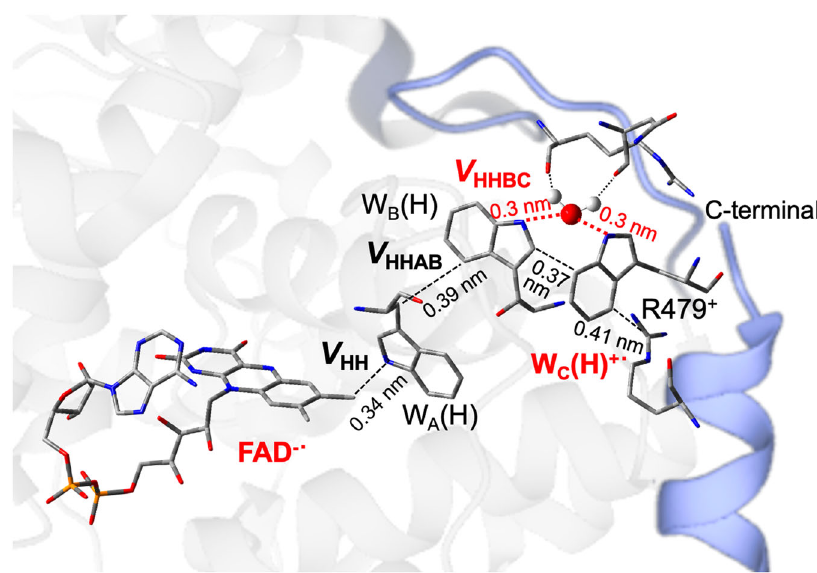
Fig. 6 Interaction routes in the ternary CS state of FAD − (cid:129) ···W C (H) + (cid:129) . Estimated based upon the x-ray structure of Synechocystis sp . PCC6803 cryptochrome DASH. Black dashed lines denote nearest-neighbor edge-to-edge separations. | V HH | ≈ | V HHAB | ≈ 140cm − 1 was estimated in FAD − (cid:129) ···W B (H) + (cid:129) at 120 K (Table 1). Bold dotted lines are the hydrogen bond separations ( R = 0.3nm) by the water for mediating the transfer integral (| V HHBC | ≈ 250cm − 1 ) at 240K. Structural rearrangements are anticipated in the blue backbones due to the cationic charge generation at W C (H) + (cid:129) .